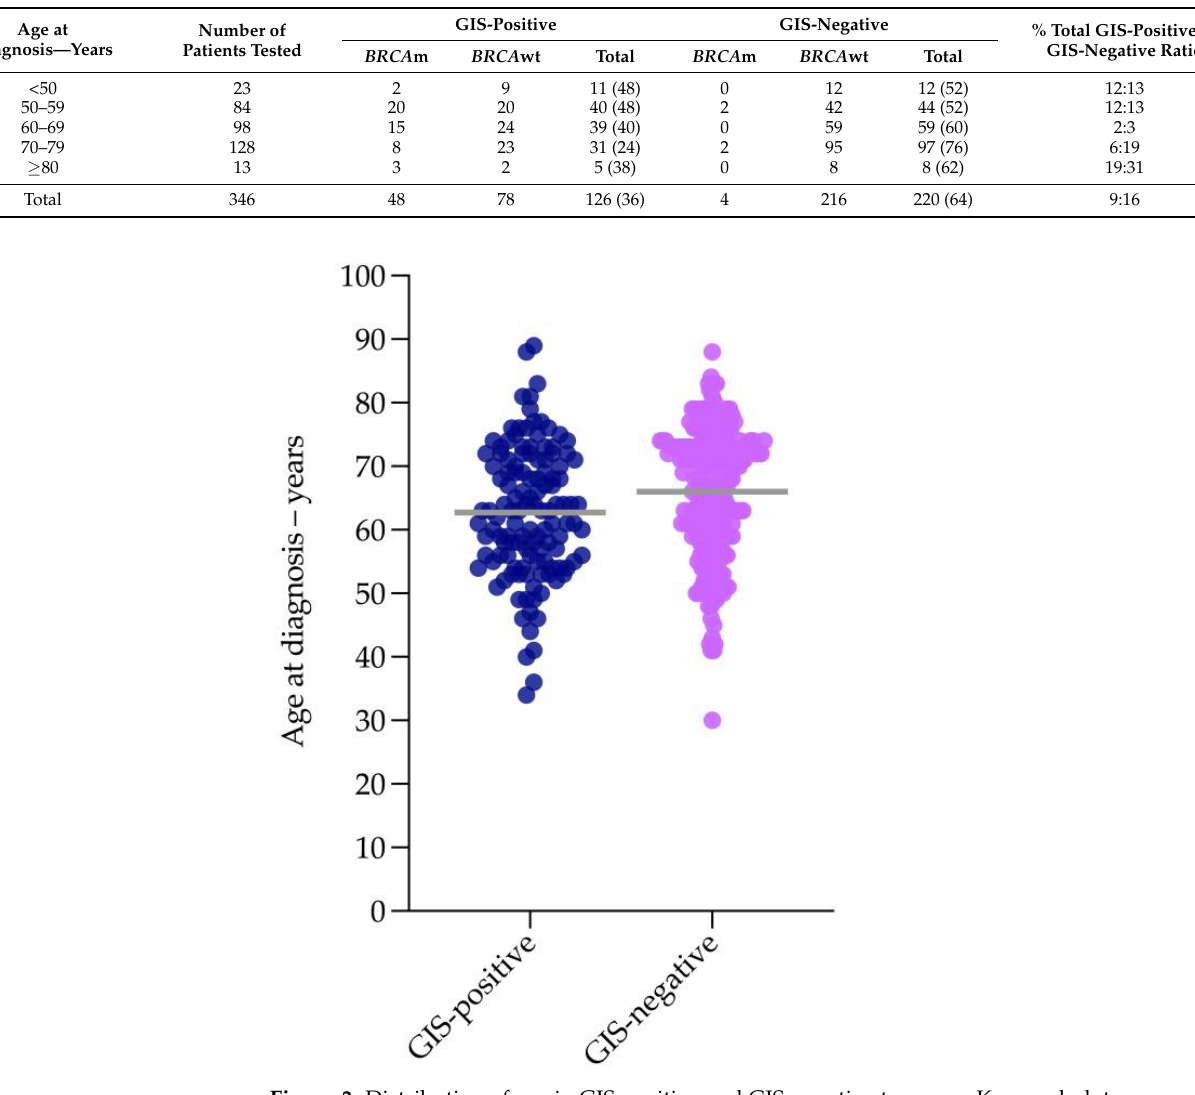
Figure 3. Distribution of age in GIS-positive and GIS-negative tumours. Key: each dot represents the age of an individual patient; grey bar represents mean average. Table 5. Homologous recombination repair genes categorized by genomic instability score status. Data are presented as number (percentage; the denominator being the ‘Total BRCA wt’). Key: a